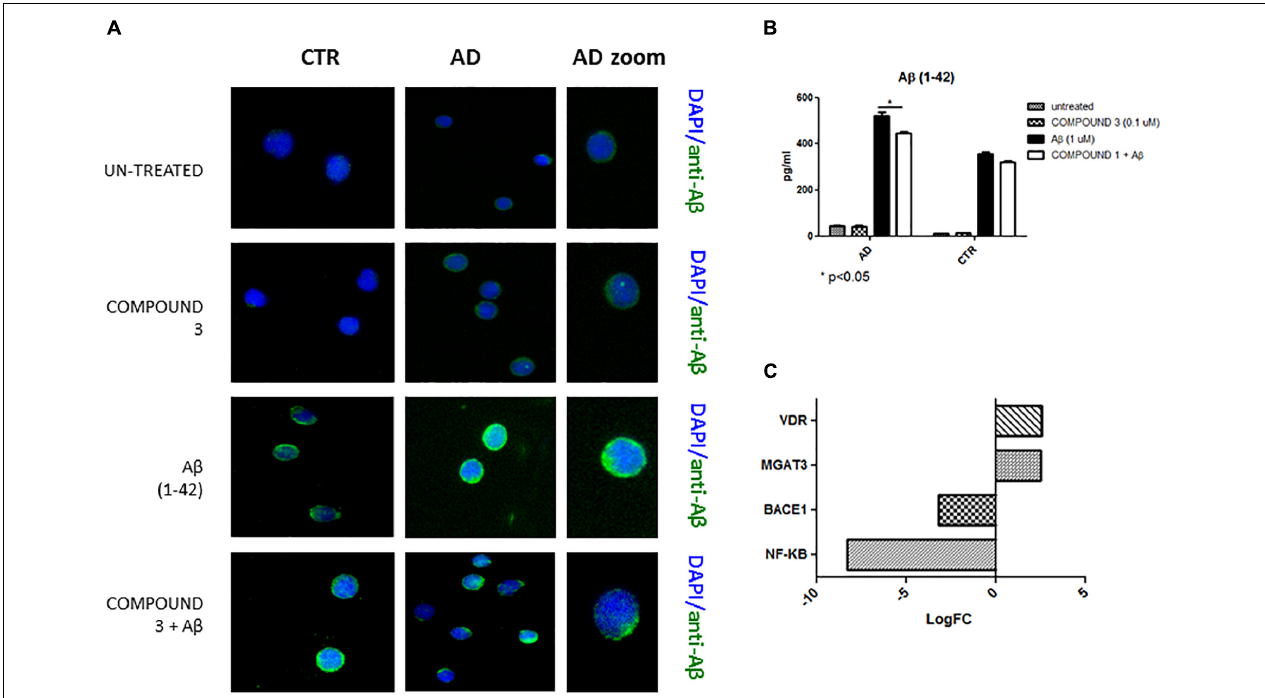
FIGURE 9 | Peripheral blood mononuclear cells from AD patients and control subjects treated with A β (48 h) or untreated, COMPOUND 3 (24 h) or COMPOUND 3 (24 h) + A β (24